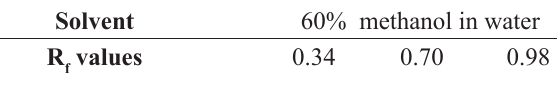
TABLE 1 - R values of broccoli extract by TLC methods. f